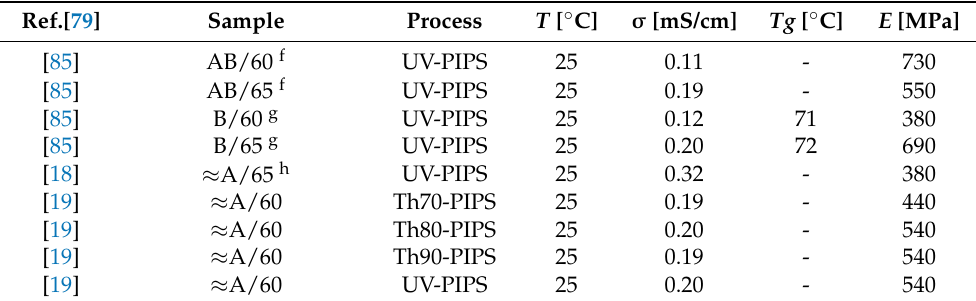
Table 3. Structural polymer electrolytes properties.